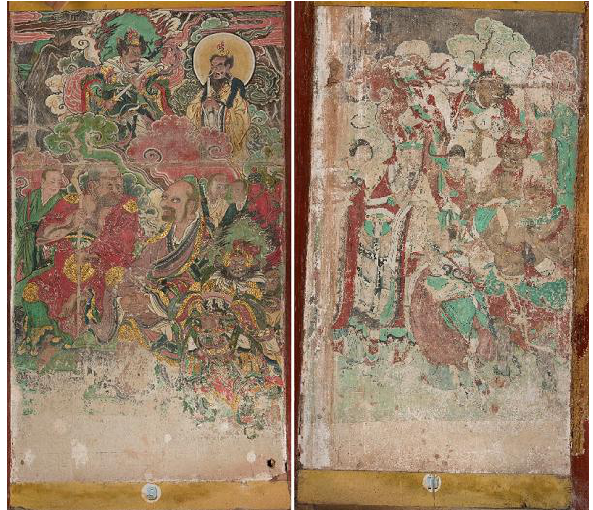
Figure 8 Image A12 (right) is part of the third period, the picture’s composition and color compared to other murals (left) are quite different presenting the mural as late